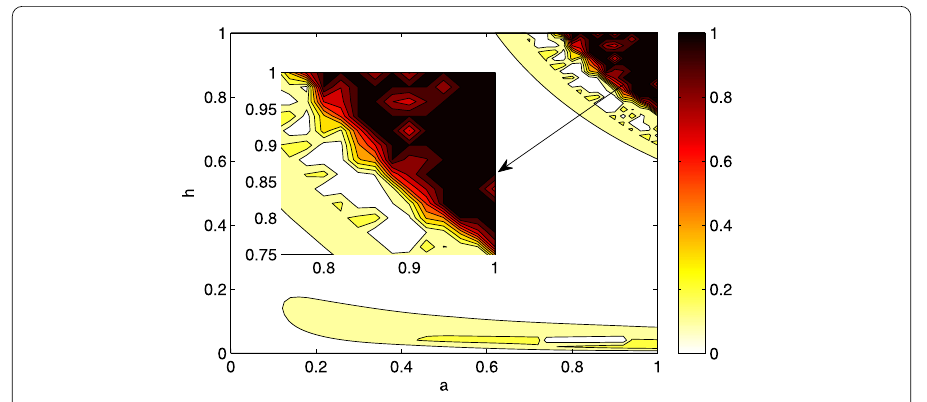
Figure 7 Chaos diagram. The chaos diagram of C 0 complexity of system (11) with α = 0.95 in the ( a , h ) parameter